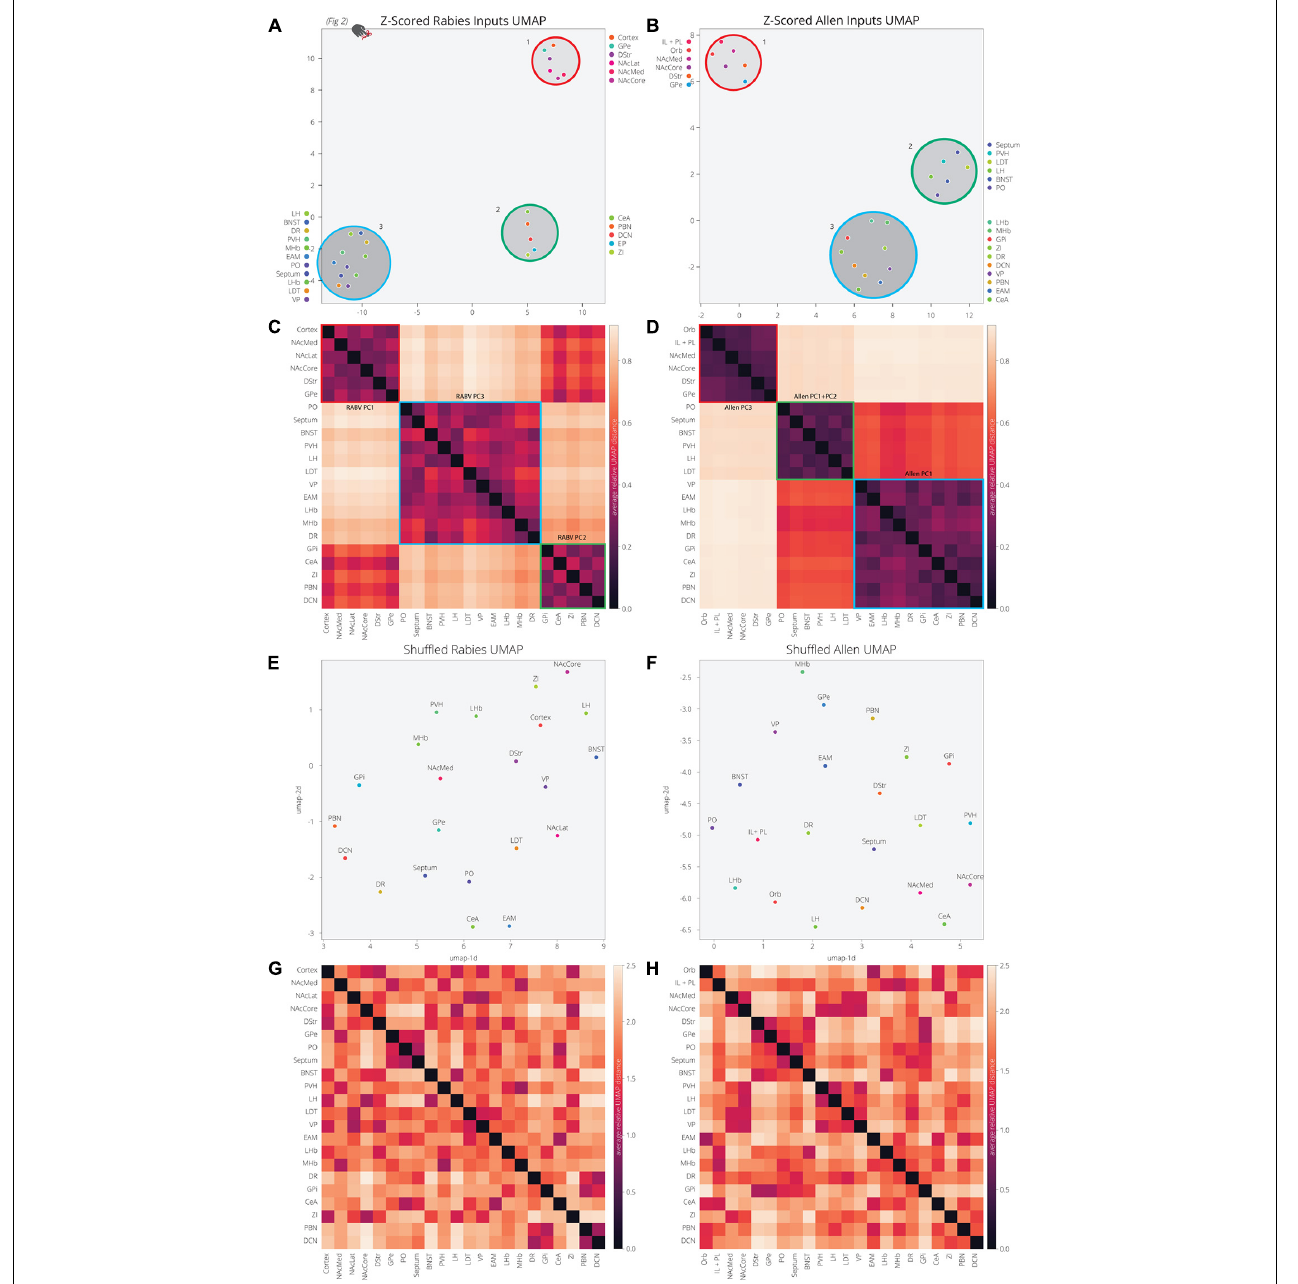
FIGURE 5 | UMAP dimensional reduction of RABV and Allen data reveal common clusters of VTA inputs. (A) Input regions are plotted in UMAP space, embedded with respect to z-scores from the RABV input mapping data. Clusters represent inputs with similar patterns of variation across the cohort. (B) Input regions are plotted in UMAP space, embedded with respect to z-scores across pixels in the Allen data. (C) Heatmap of pairwise distances (averaged across 20 UMAP embeddings) for the RABV input data. Regions are grouped according to hierarchical clusters. Clusters are highlighted to match the clusters above in the UMAP plot; they are also annotated according to which principal components to which the regions contribute. Regions are grouped to line up with the Allen clusters. (D) Heatmap of pairwise distances (averaged across 20 UMAP embeddings) for the Allen input data. (E–H) Same plots as panels (A–D) , but UMAP was run on scrambled data. For each region, z-score values were scrambled across mouse brains for RABV data, or pixel coordinate for the Allen